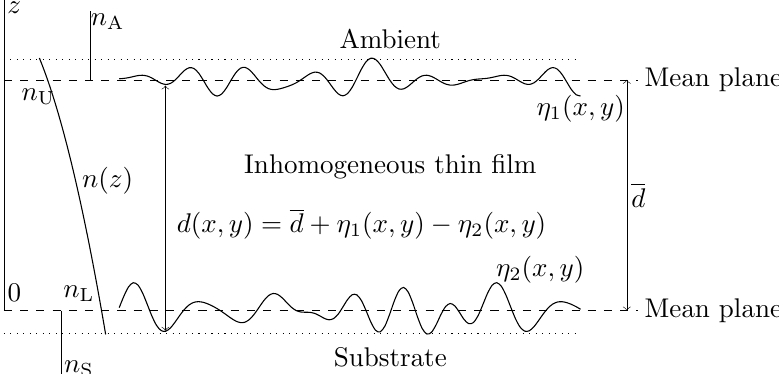
Figure 2. Schematic diagram of the inhomogeneous thin film with rough